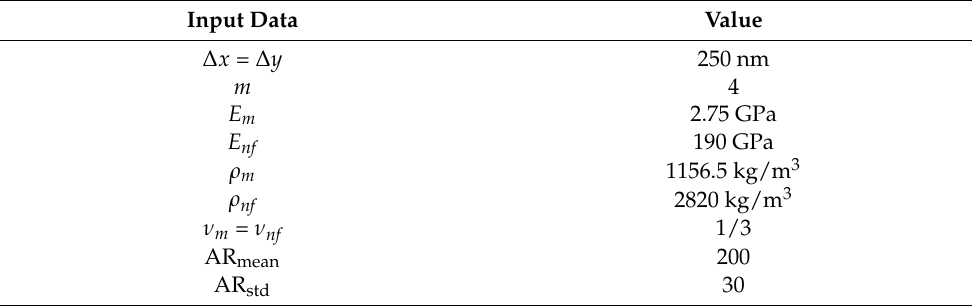
Table 6. Input data for the calibration